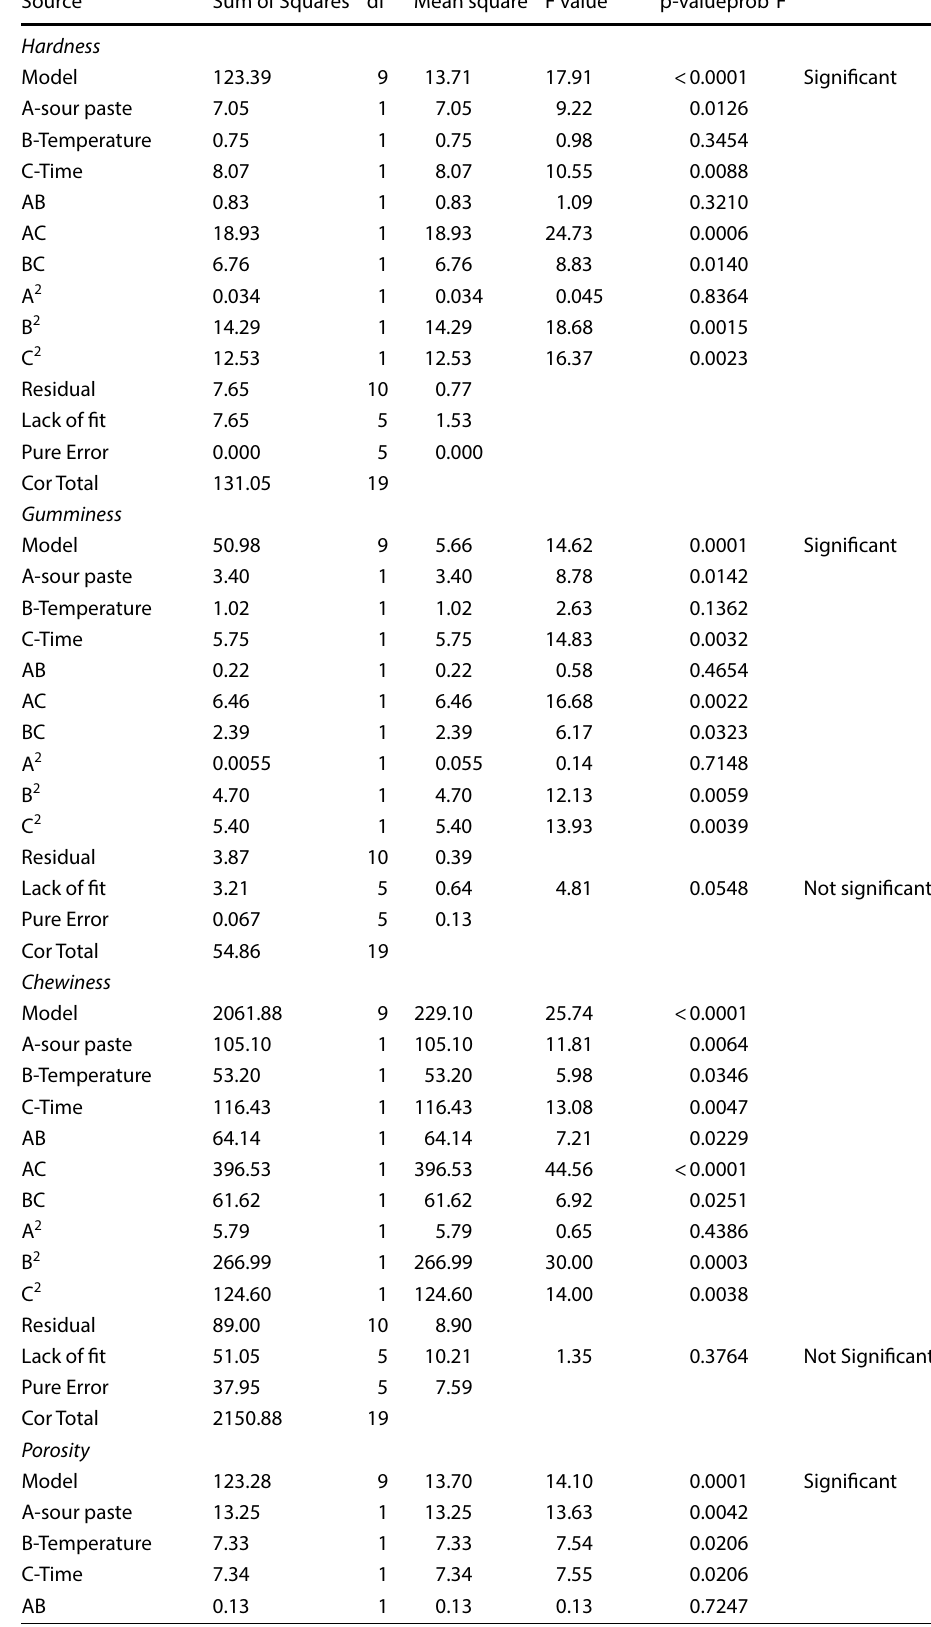
Table 3 ANOVA table for predictive models of different responses related to the characteristics of